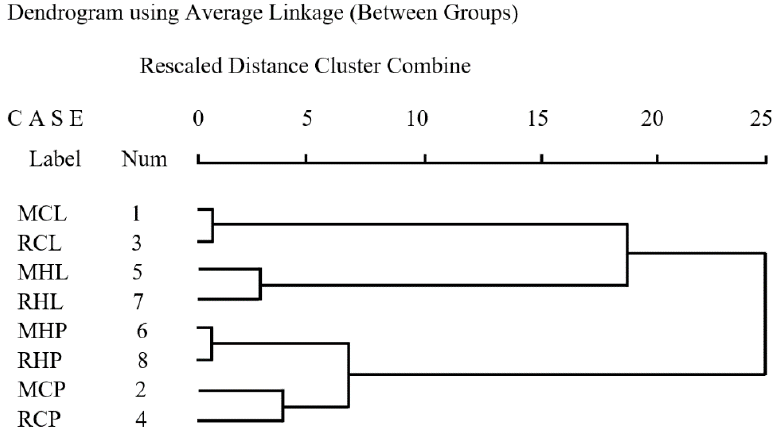
Figure 2. Dendrograms based on the chemical components and contents of Clausena lansium. Num: number.